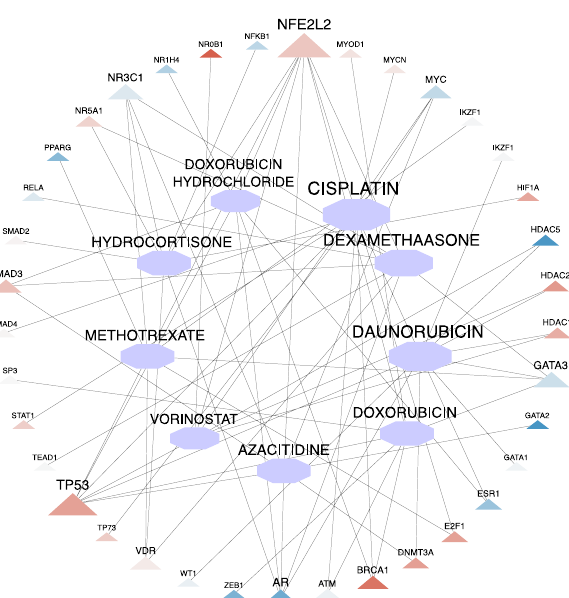
Figure 6. The expression level of hub drugs’ target TFs in NSCLC group compared to the normal group. The triangle and hexagon shapes represent TF genes and drugs, respectively. The size of a node indicates its degree (this figure was drawn in the Cytoscape 43 v.3.8.2